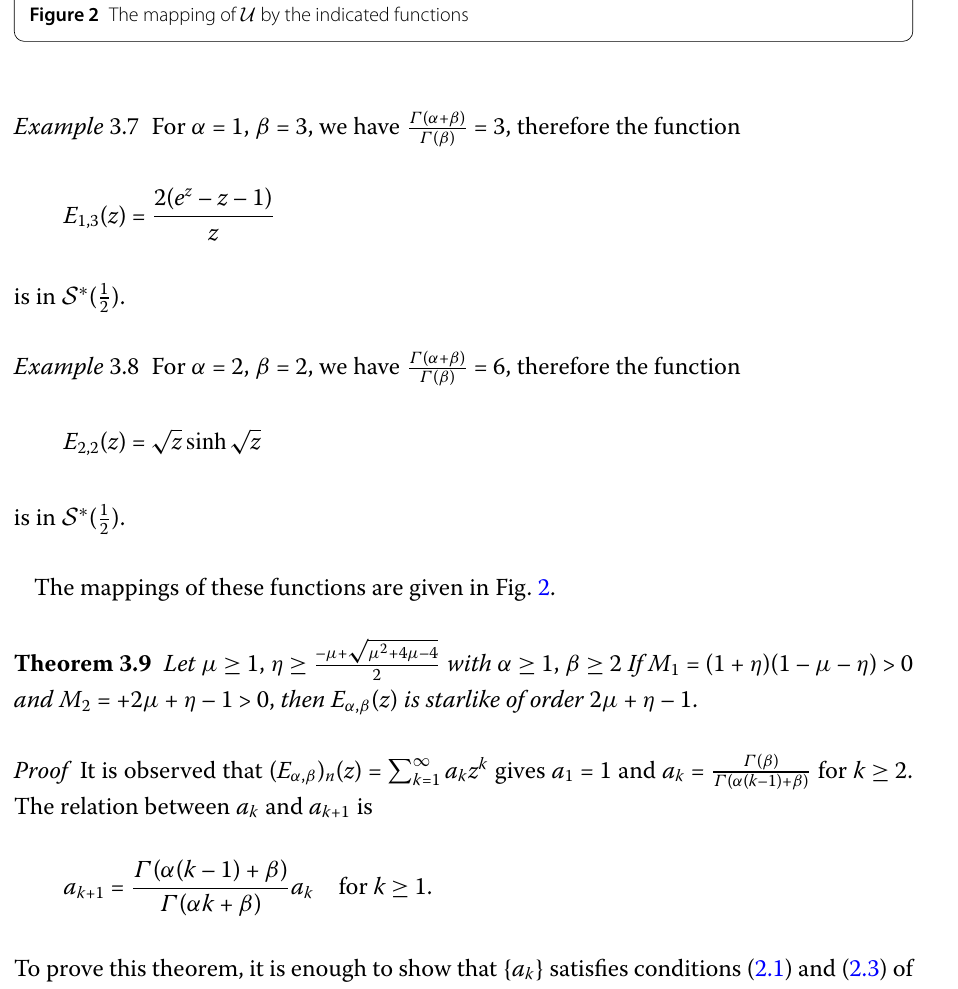
Figure 2 The mapping of U by the indicated functions